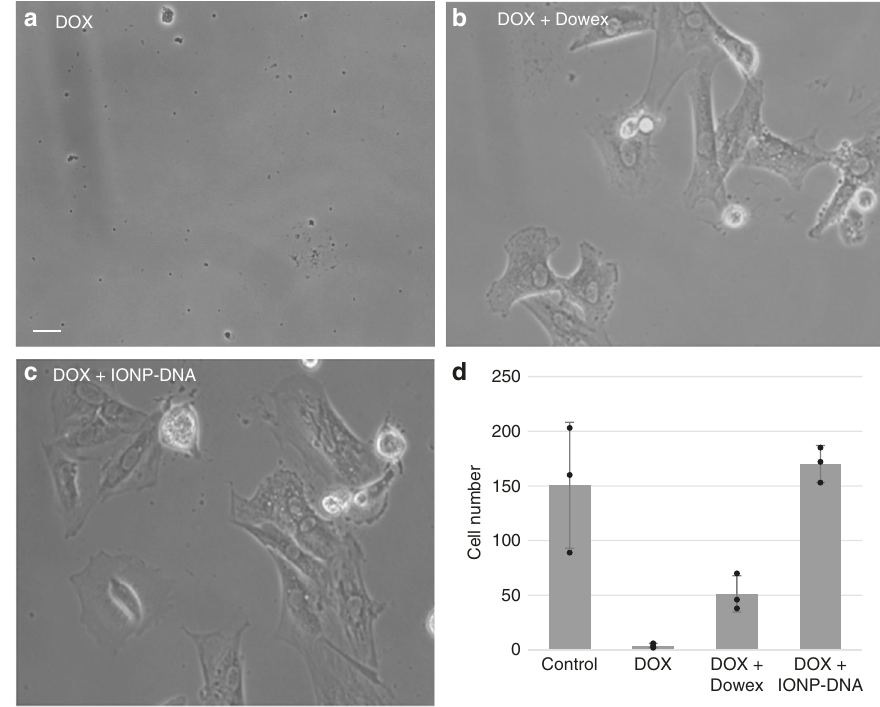
Fig. 4 IONP-HN3-DNA rescue cultured cells from DOX toxicity (scale bar = 5 μ m). a Rat heart myoblasts H9C2 cultured with DOX (0.05 mg/mL) — myoblasts are killed by adding DOX to culture (DOX, d ). b Myoblasts treated with DOX (0.05 mg/mL) and 0.19 g Dowex ion-exchange resin beads — myoblasts are partially rescued ((DOX + Dowex, d ). c Myoblasts treated with DOX (0.05 mg/mL) and 0.19 g IONP-HN3-DNA — myoblasts are completely rescued (DOX + IONP-DNA, d ). d Cell counts for each experimental condition; error bars = 1 standard deviation ( n = 3)